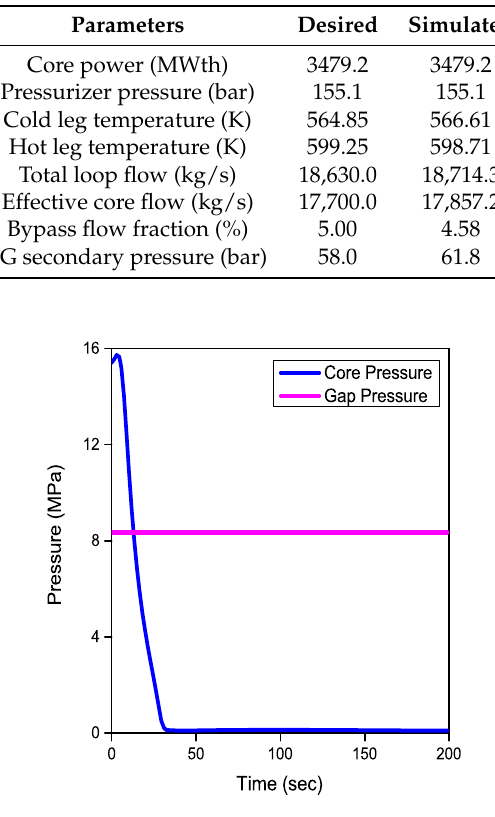
Figure 3. Pressure of fuel gap and reactor core during the